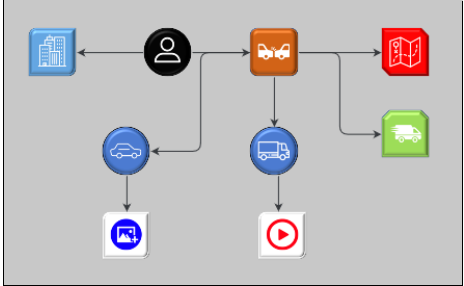
Figure 3. Example of incident